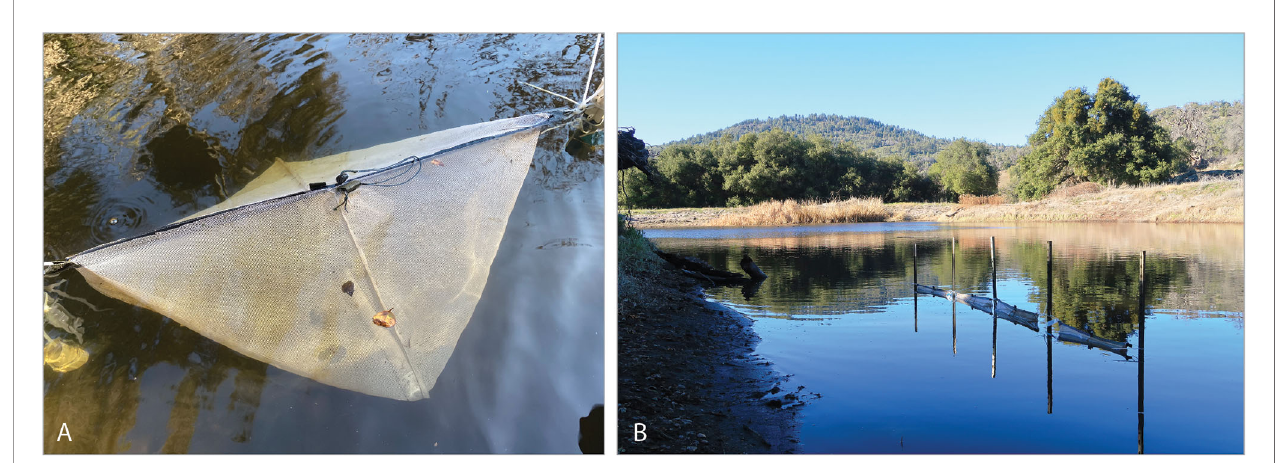
FIGURE 3 | (A) Example of the modi fi ed egg mass holding pen. (B) Example of consecutive holding pens ( n = 4) attached to